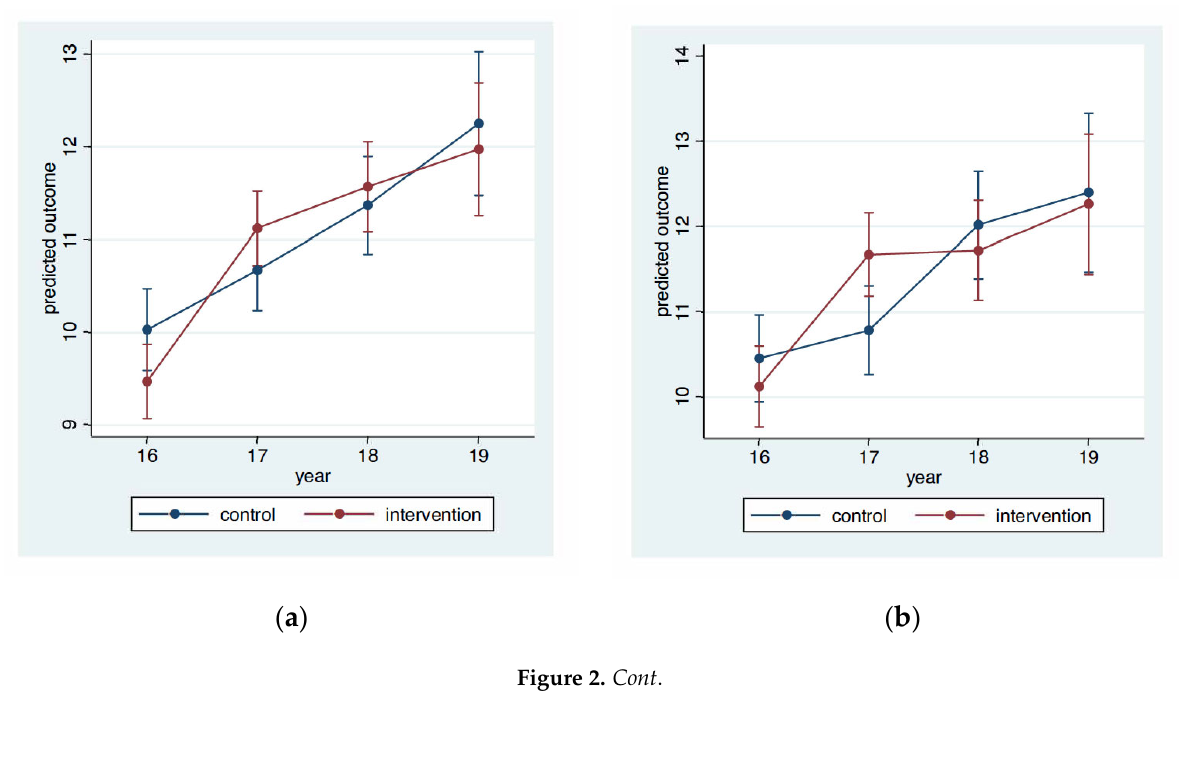
Table 5. Change scores from baseline to follow-up by intervention group. Motor skills measured using MABC-2 in preschool children.